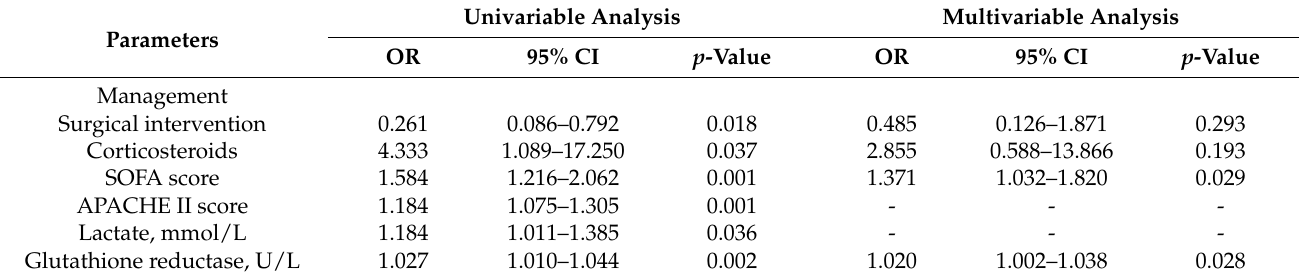
Table 3. Multivariable analysis of the factors significantly associated with in-hospital survival of septic shock patients. Univariable Parameters